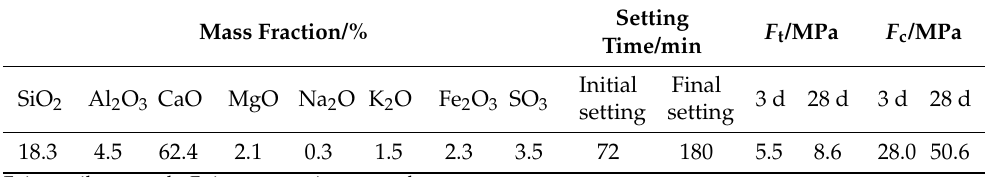
Table 1. Physical and chemical properties of cement.